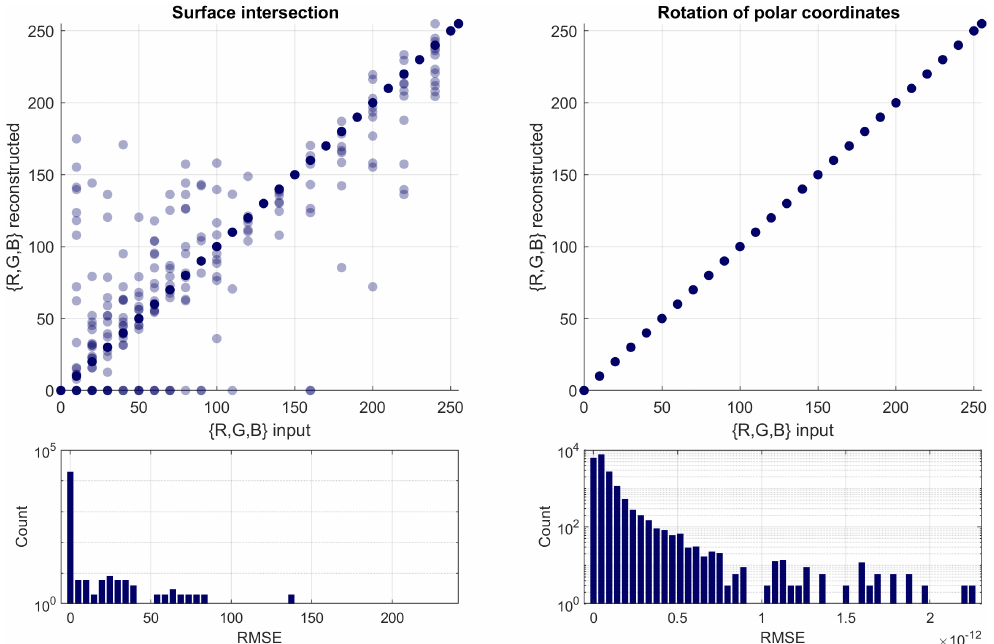
Figure 4. Comparison between ARC-to-RGB inversion based on surface intersection [6] ( left ), and the rotation of the polar coordinates [29] ( right ). The top row shows the correlation between the input and reconstruction, measured in terms of the Pearson linear coefficient, respectively, as 0.9994 and 1.0000. The bottom row shows the details of the error distribution: note the difference in the horizontal